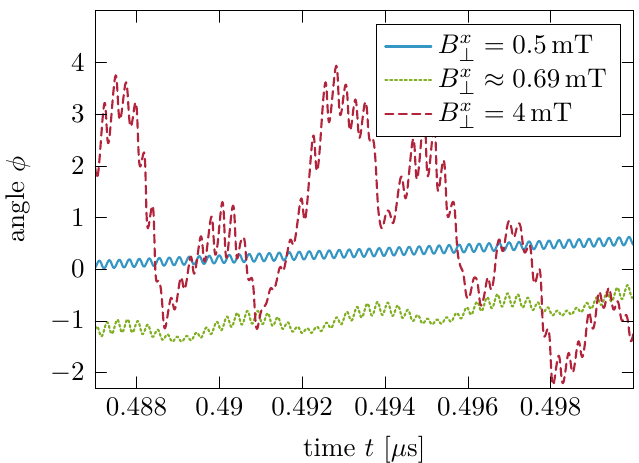
Figure 7: Angle φ ( t ) of a single spin as a function of time for increasing amplitude of the oscillating magnetic field, (parameters as in Fig. 3, with driving frequency f = 4.15 GHz), see also supplementary videos for an animated version. For small = 0.5 mT (solid blue line), the Archimedean screw solution is obtained. fields, B x ⊥ Fast oscillations of frequency ω trigger the screw-like motion of the conical state (cid:28) ω giving rise to the finite average slope of φ ( t ) . For larger with frequency ω screw = 0.69 mT (dotted green line) a “time quasicrystal“ forms, giving rise to field, B x ⊥ = 0.33 GHz matching the instability predicted a modulation with a frequency f new from spin wave theory ( ω ≈ 0.16, red region in Fig. 4(b). For even stronger driving, = 4 mT (dashed red line), one enters a chaotic regime, see also Fig. B x ⊥